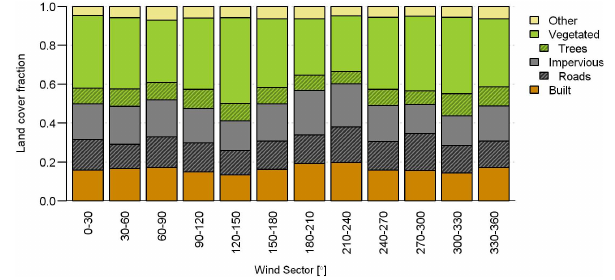
Fig. 2. Land cover fractions for 30 ◦ wind sectors within a radius of 500m around the flux mast.